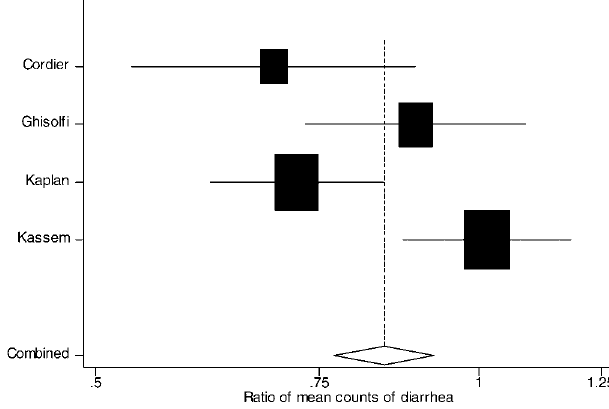
Figure 5. Meta-Analysis of Ratio of Mean Counts of Diarrheal stools at 24 h among Those on Loperamide Compared with Controls The x -axis uses the log scale. Fixed-effects ratio of count of stools at 24 h: 0.84 (95% CI: 0.77 to 0.92). Random-effects ratio of count of stools at 24 h: 0.83 (95% CI: 0.69 to 1.00). Test for heterogeneity, p , 0.001